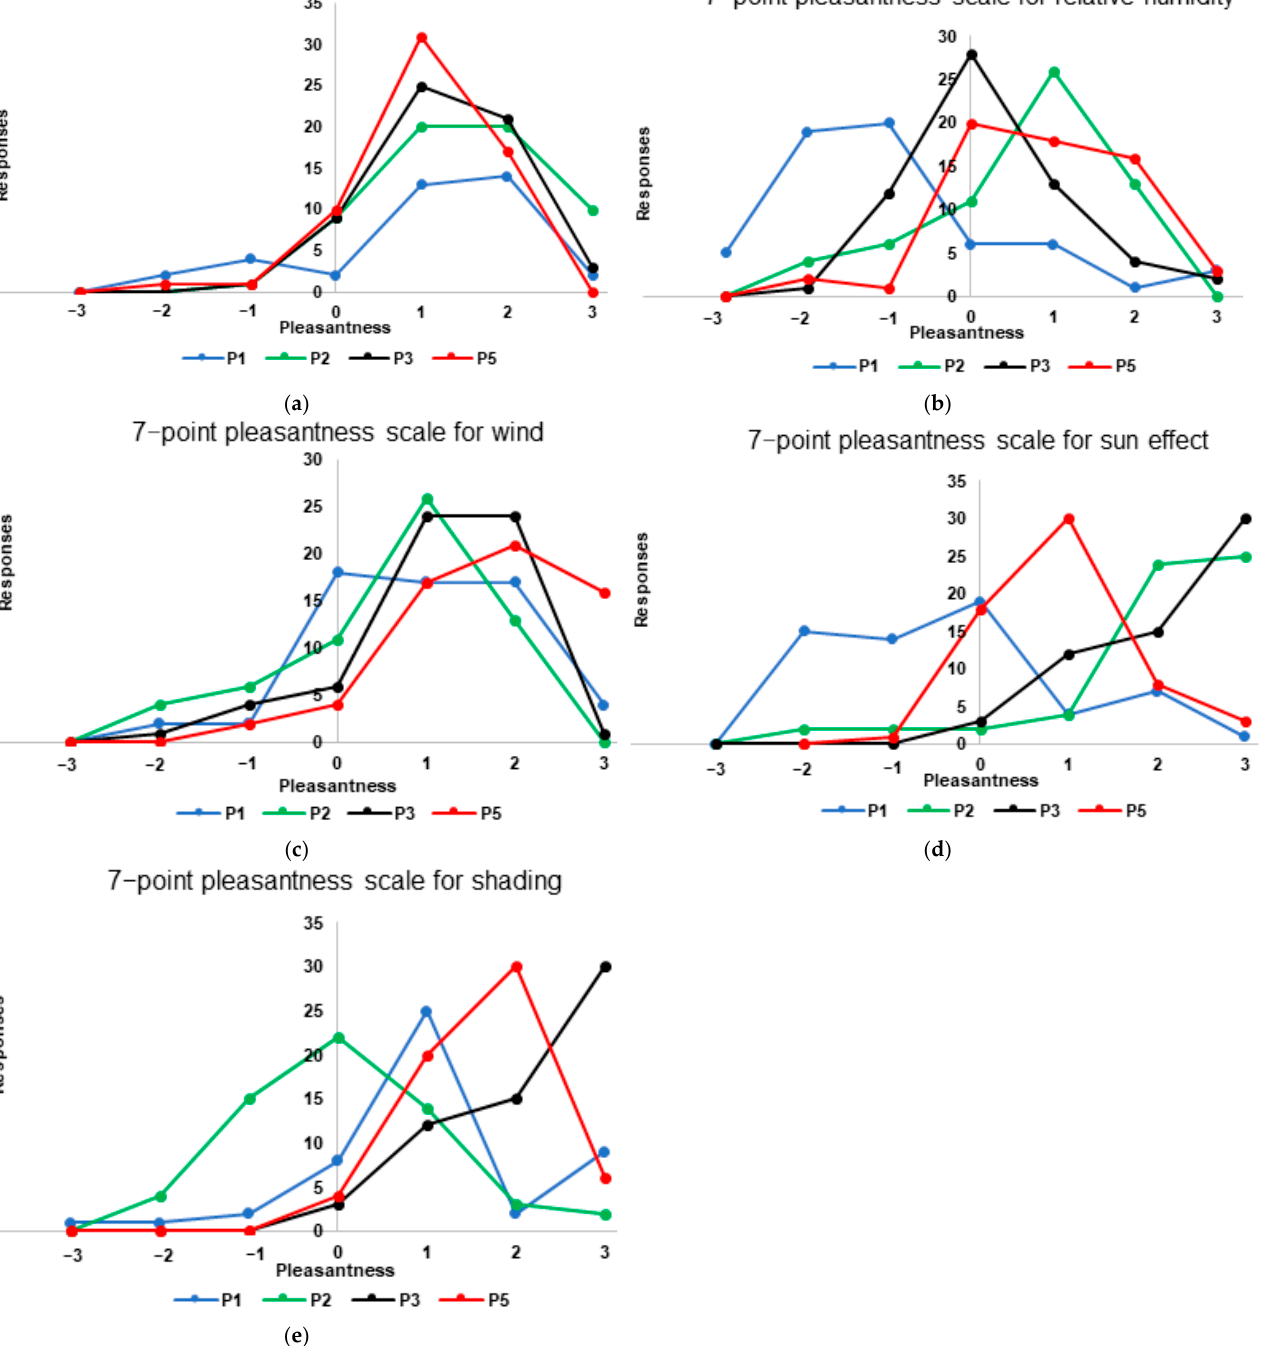
Figure A3. The 7 ‐ point pleasantness scale of climatic parameters at points with different sky view factors. Air temperature ( a ), relative humidity ( b ), wind ( c ), sun effect ( d ), shading ( e ).